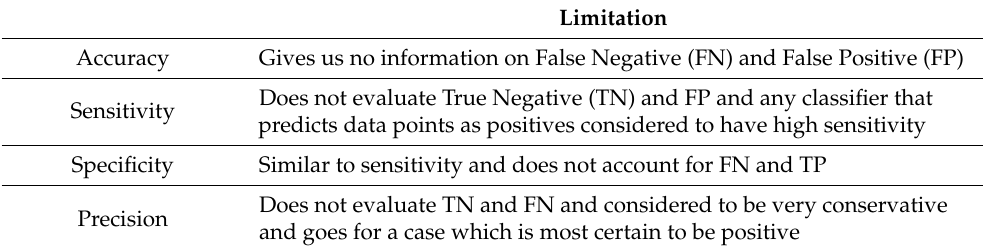
Table 6. Metrics